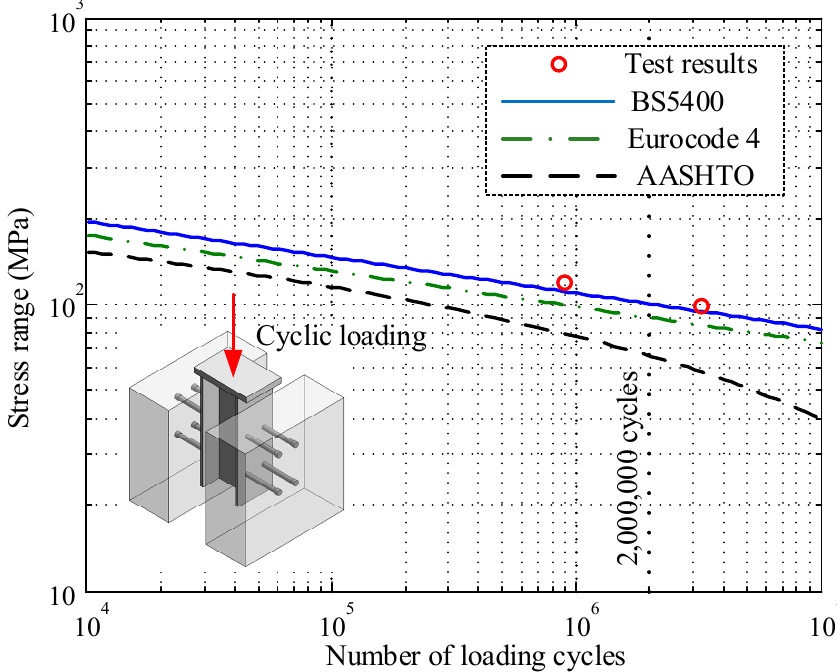
Figure 7. S – N curves in different specifications and fatigue test results of headed shear studs. For specimen S-2, strain gauges Sr7 near a good stud (stud No. 7) and Sr6 near